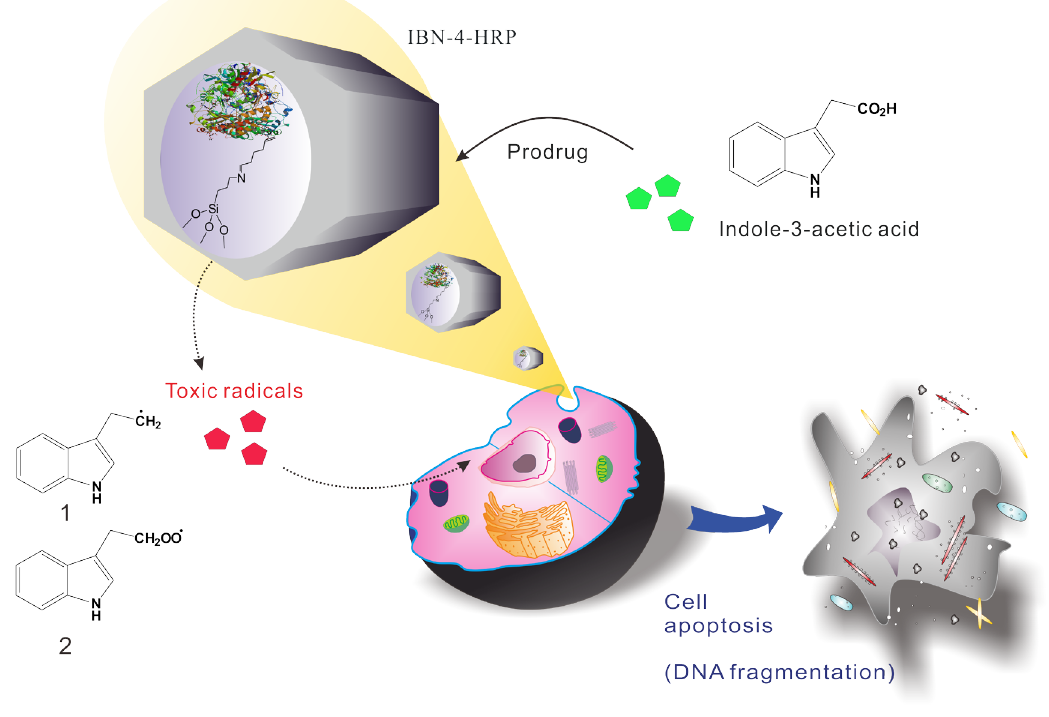
Figure 1. Schematic representation of enzyme prodrug therapy using